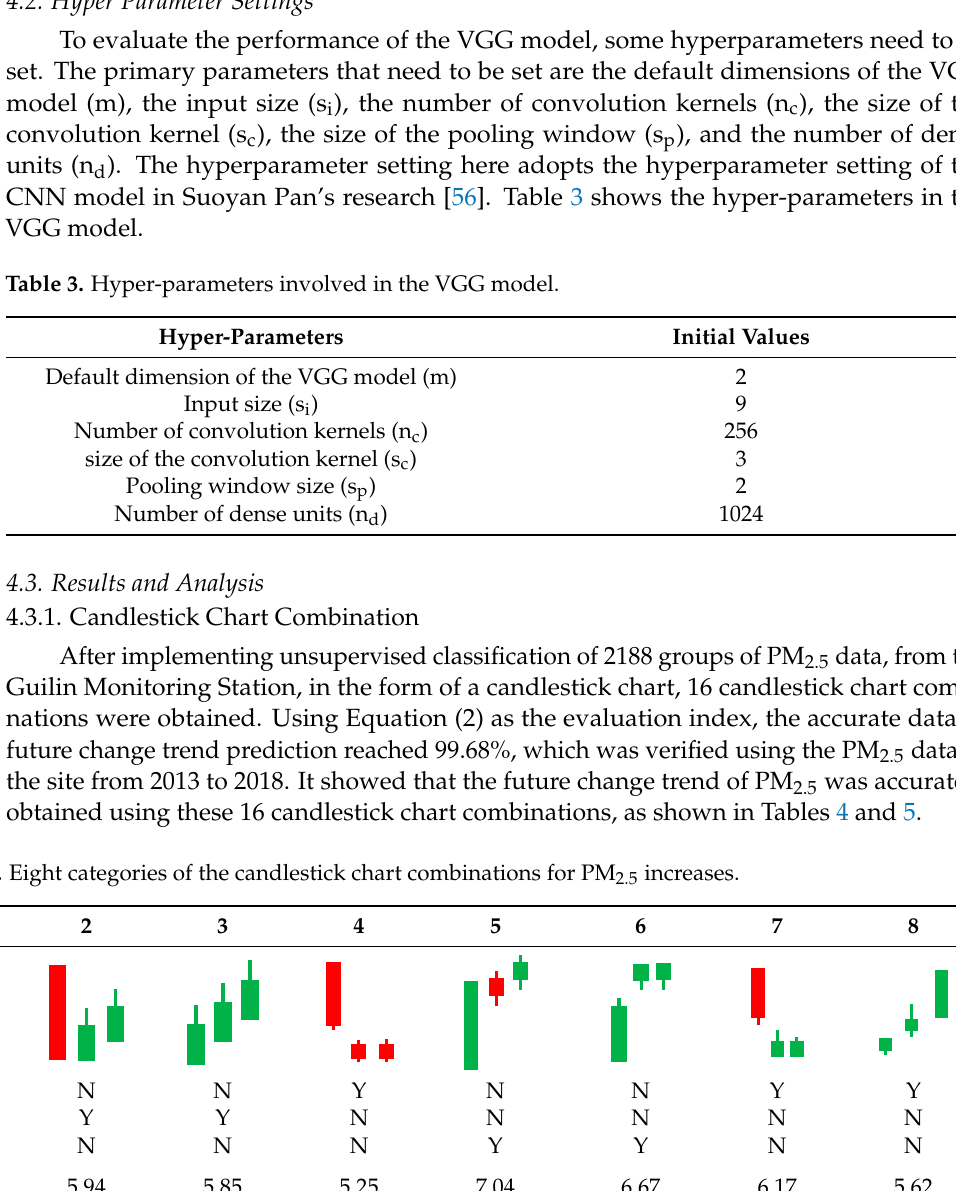
Table 3. Hyper-parameters involved in the VGG model.